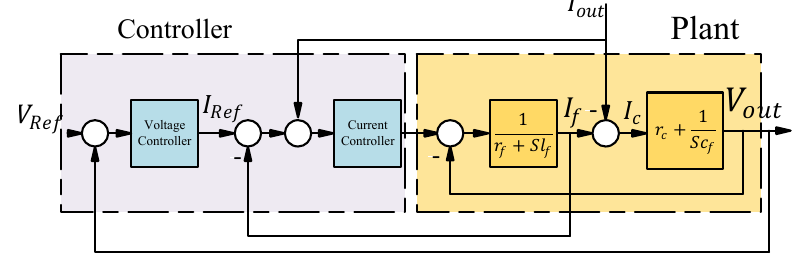
Figure 4. Plant for voltage and current